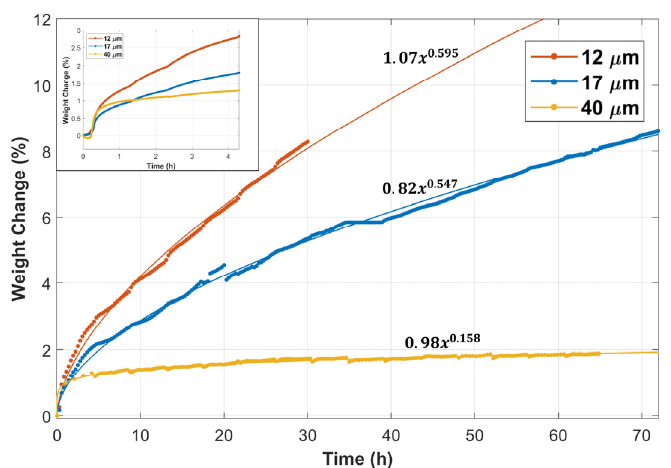
Figure 2. Percentage weight change of the 12, 17, and 40 µ m FeCrAl fibers versus time during multiple MSHT cycles. Inset: Percentage weight change of the fibers during the first MSHT